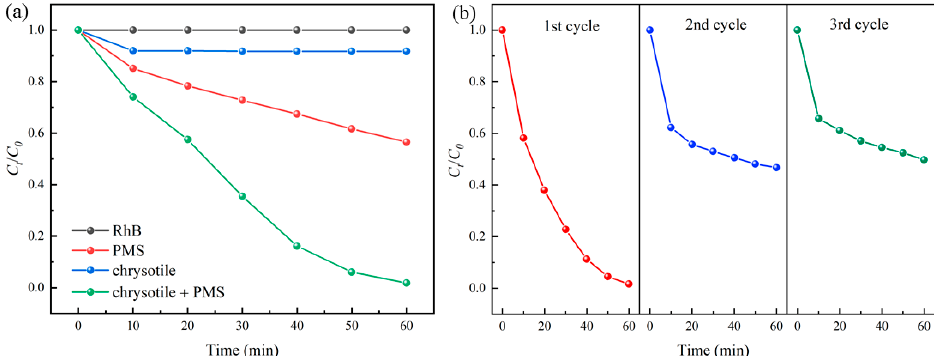
Figure 1. The degradation of RhB in the presence of chrysotile ( a ) and reusability of chrysotile ( b ). Control conditions: (PMS) = 1 mM, (chrysotile) = 1 g/L, (RhB) = 10 mg/L, temperature = 30 °C.